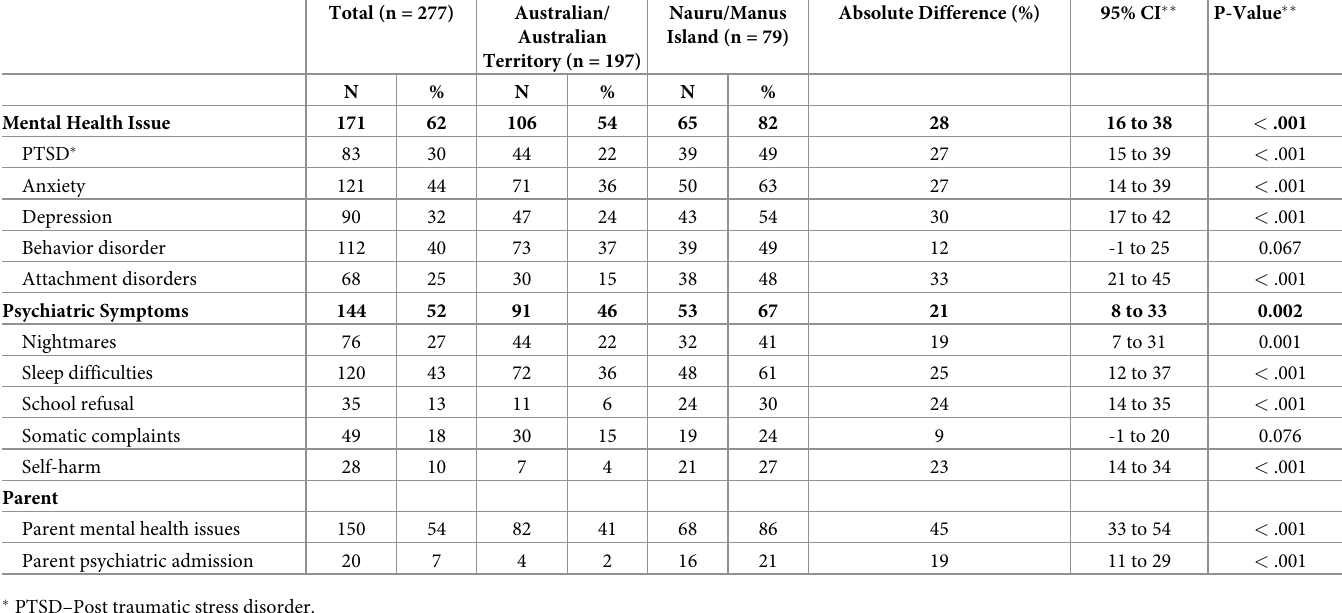
Table 3. Mental health issues for children experiencing